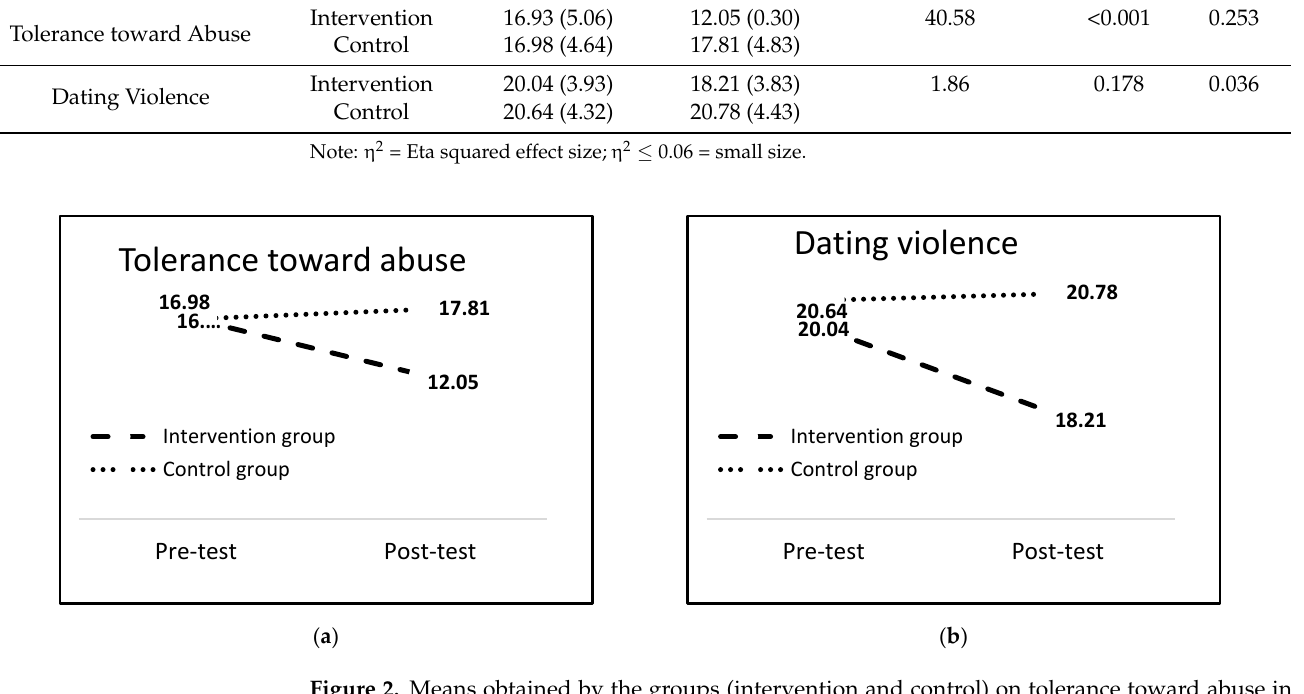
Figure 2. Means obtained by the groups (intervention and control) on tolerance toward abuse in romantic relationships ( a ) and dating violence perpetration ( b ).